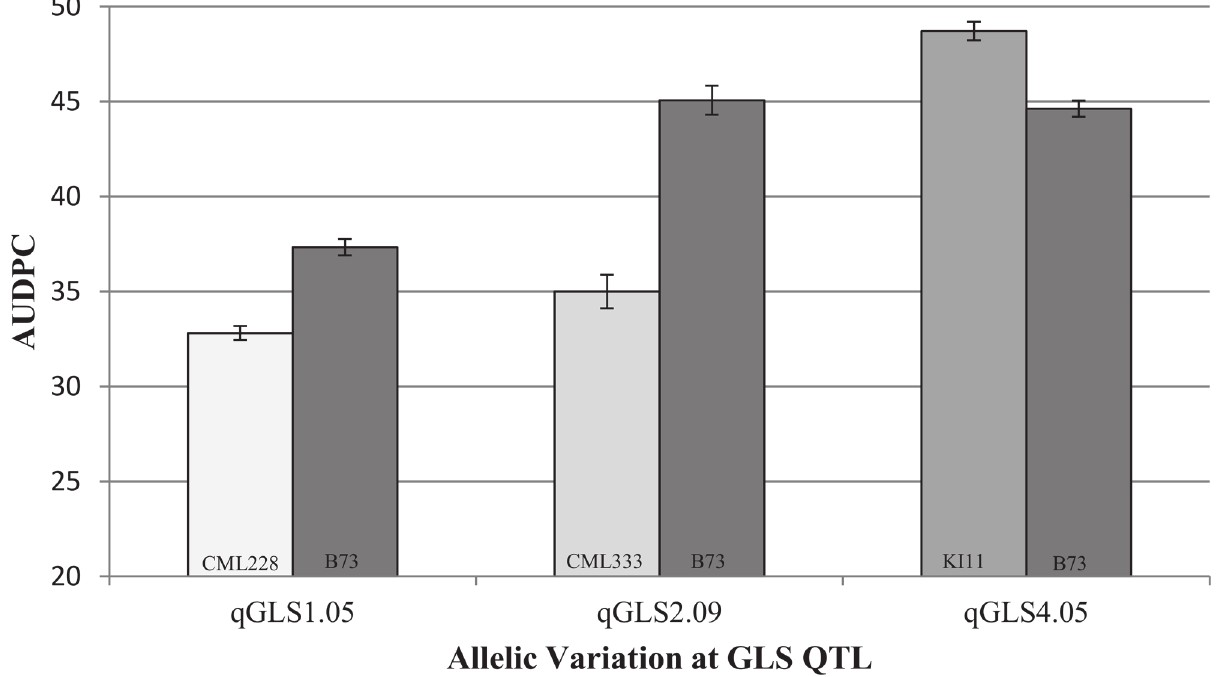
Fig 3. Confirmation of three disease quantitative trait loci using near isogenic lines. Disease development [area under the disease progress curve (AUDPC)]is indicated among heterogeneous inbred family lines across three gray leaf spot quantitative trait